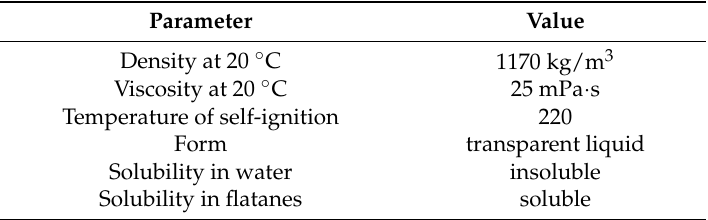
Table 2. Properties of the Butanox M-60 Hardener (information from the product’s card).